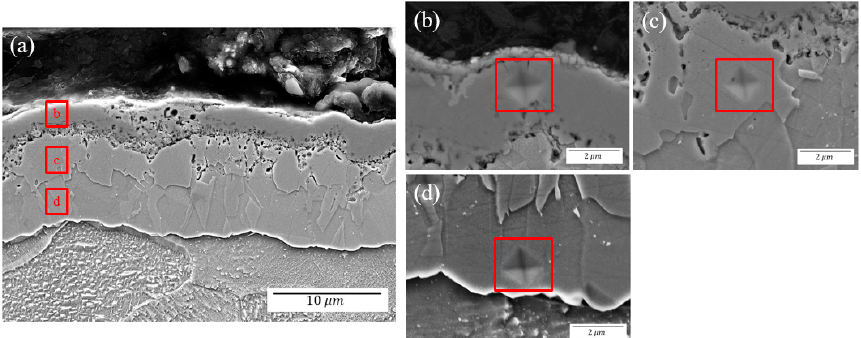
Figure 5. SEM image and impression of indenter on each phase after nanohardness test for air-specimen: ( a ) SEM image; ( b ) magnetite; ( c ) epsilon; ( d ) gamma prime.